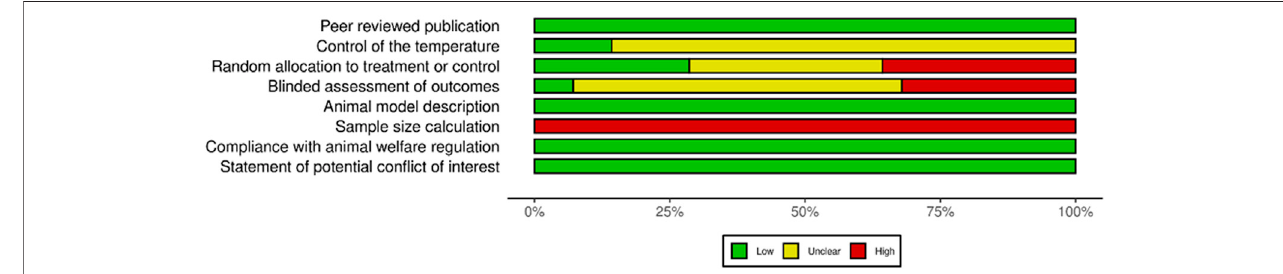
FIGURE 4 | Implantation sites of pullulan and/or dextran-based scaffolds to assess their potential for bone regeneration. Created with BioRender.com.